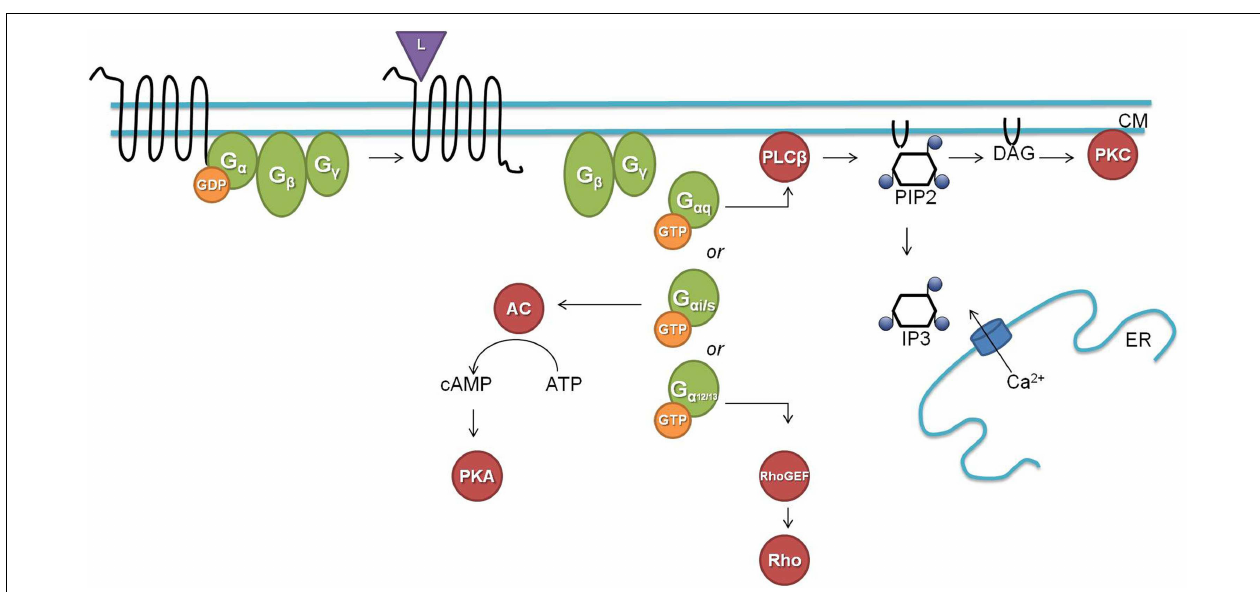
FIGURE 1 |The classical G protein signaling pathway (L, ligand; CM, cell membrane; GDP, guanosine diphosphate; GTP, guanosine triphosphate; AC, adenylate cyclase; cAMP, cyclic adenosine monophosphate;ATP, adenosine triphosphate; PKA, protein kinaseA; PLC β , phospholipase C β ; PIP2, phosphatidylinositol 4,5-bisphosphate; DAG, diacylglycerol; IP3, inositol-1,4,5-trisphosphate; ER, endoplasmatic reticulum; PKC, protein kinase C; GEF, guanine nucleotide exchange